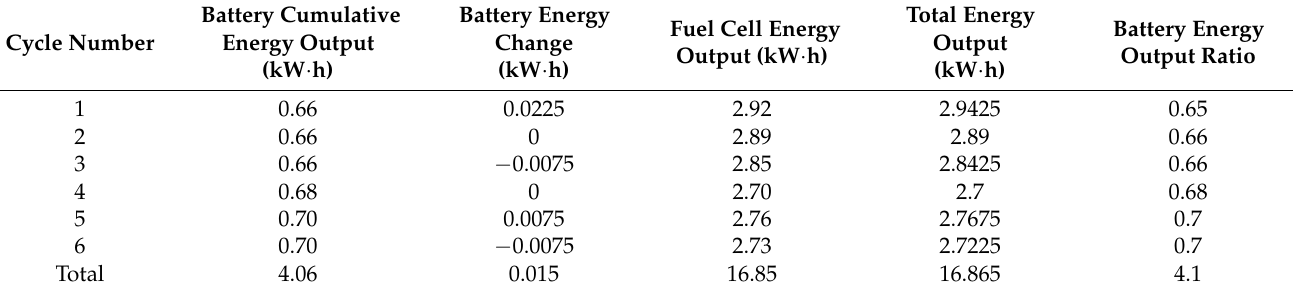
Table 3. The energy output of vehicle A.